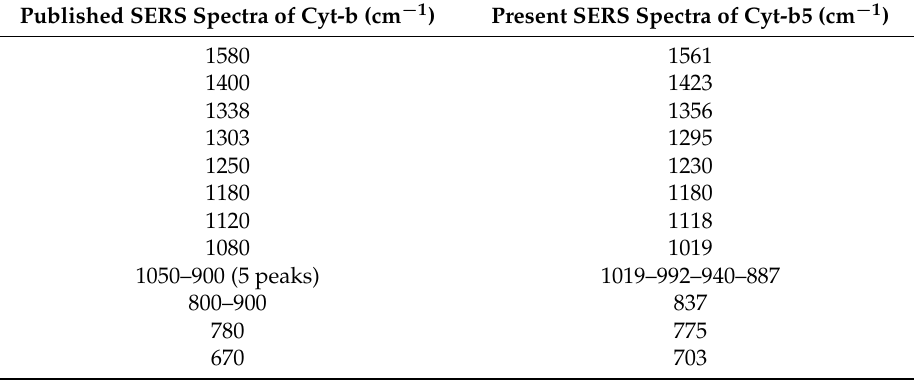
Table 4. SERS vibrational spectra of Cyt-b5 with estimated peak value from published work [33] and compared with the spectra obtained on the present study using annealed gold nanostructures developed on pre-treated glow-discharge cleaned